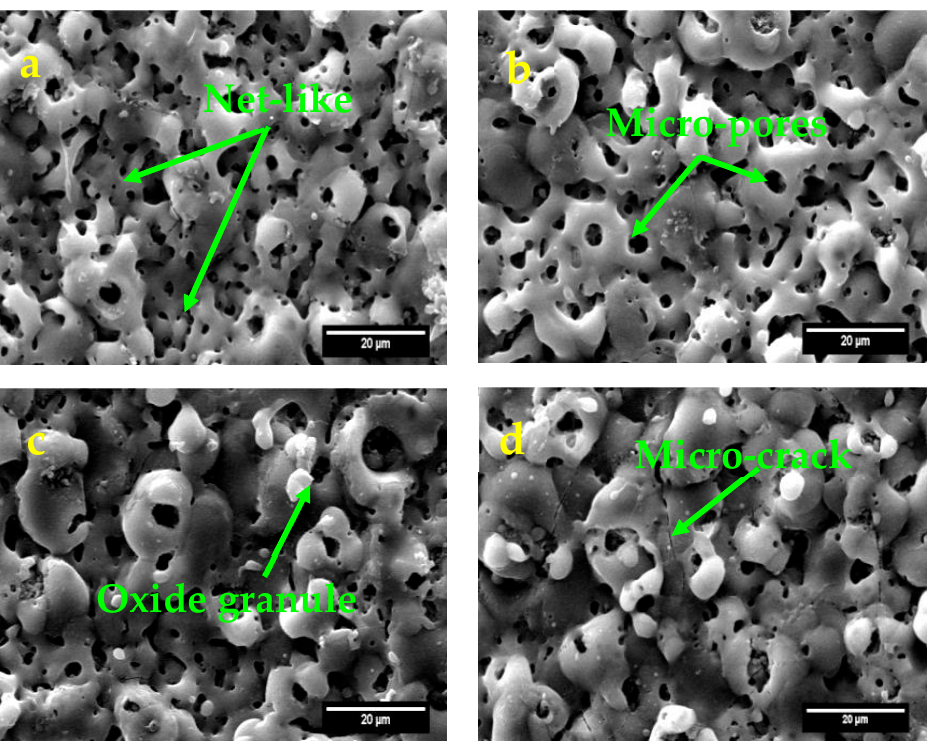
Figure 3. Surface morphology of the coatings produced using ( a ) U, ( b ) B1, ( c ) B2 and ( d ) B3 waveforms. Table 2. Surface porosity percent and average pore size of the plasma electrolytic oxidation(PEO) coatings produced using U, B1, B2 and B3 waveforms.